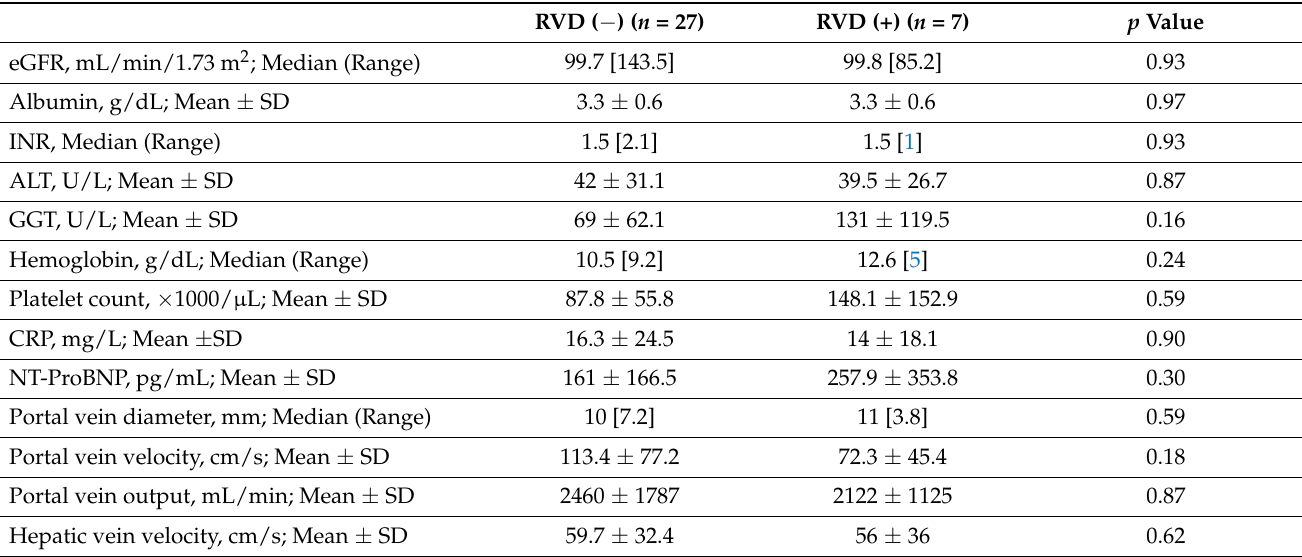
Table 2. Preoperative laboratory test results and hepatic and portal venous duplex US findings of the liver transplant recipients.